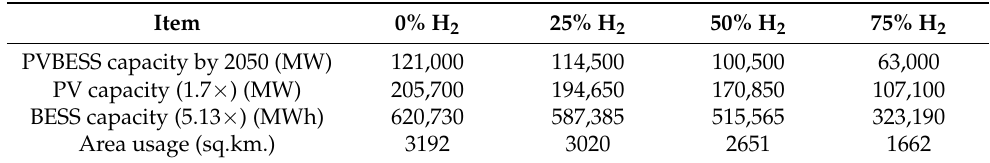
Table 3. Land use for PVBESS installation by 2050.